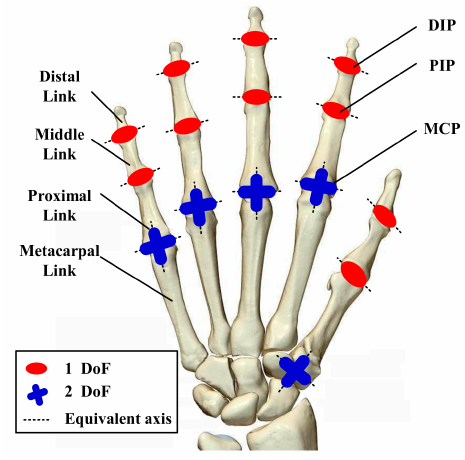
Figure 2. Equivalent model of the human hand.